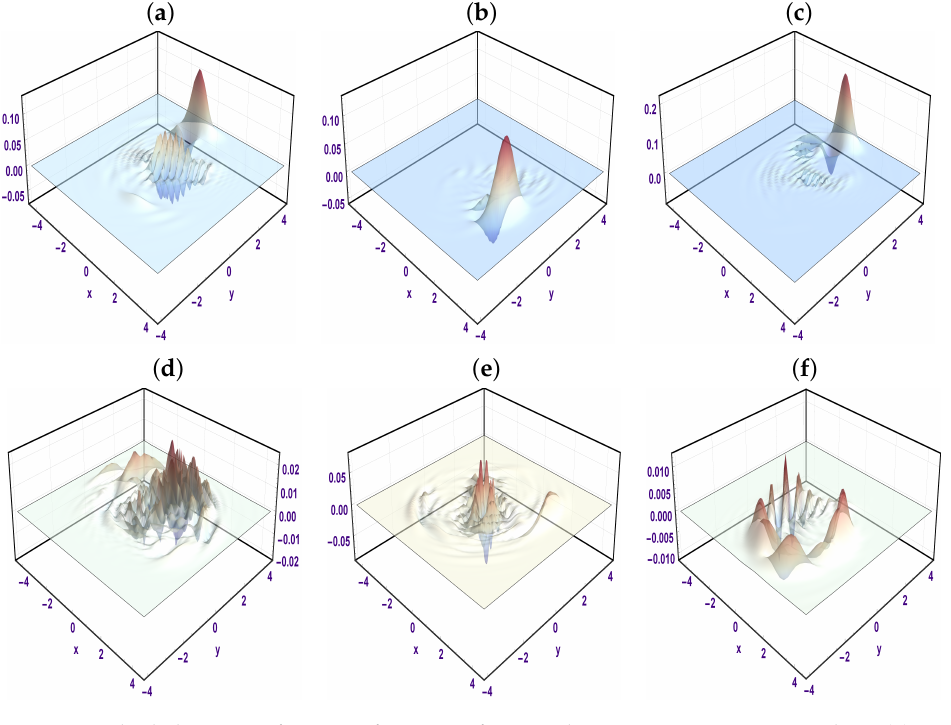
Figure 1. The behaviour of W as a function of x , y , where Γ m = x + iy = Γ c where ( a ) θ = 0, λ 1 = 1 = λ 2 = λ 3 ; ( b ) θ = π /4, λ 1 = 1 = λ 2 = λ 3 ; ( c ) θ = π /2, λ 1 = 1 = λ 2 = λ 3 ; ( d ) θ = π /4, λ 3 = 2, λ 1 = 1 = λ 2 ; ( e ) θ = π /4, λ 2 = 2, λ 1 = 1 = λ 3 ; ( f ) θ = π /4, λ 1 = 2, λ 2 = 1 = λ 3